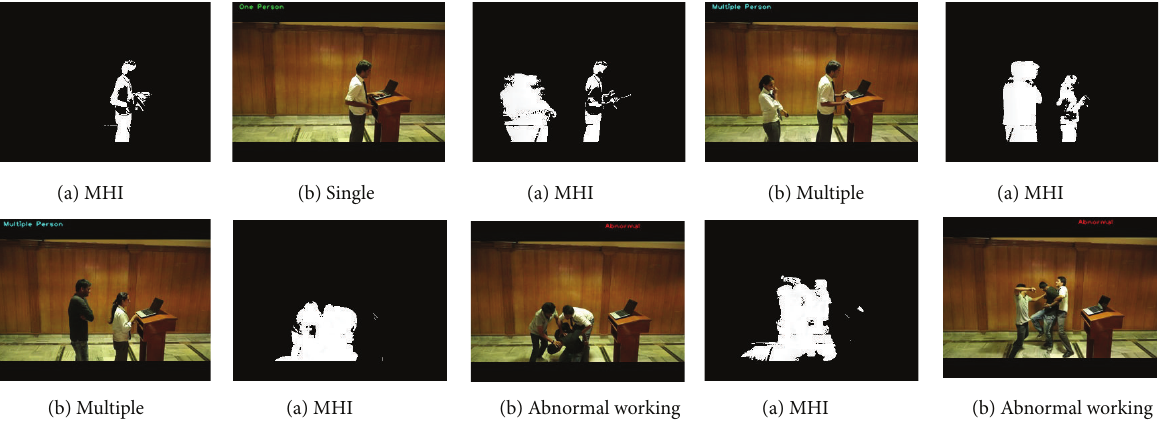
was 92.31% for 5 MHI frames, 95.73% for 10 MHI